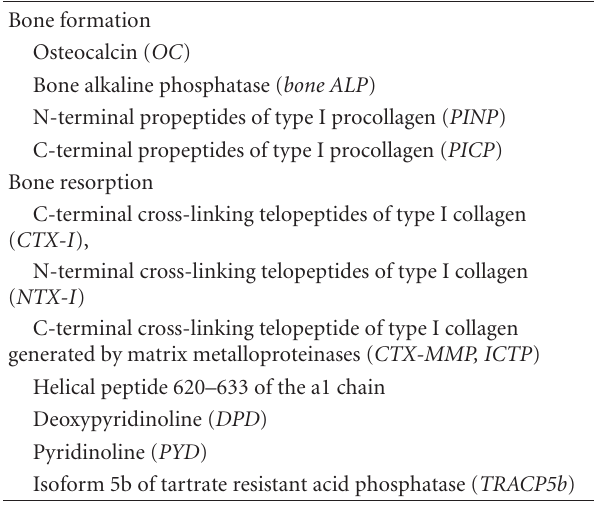
Table 1: Biochemical bone turnover markers. Bone